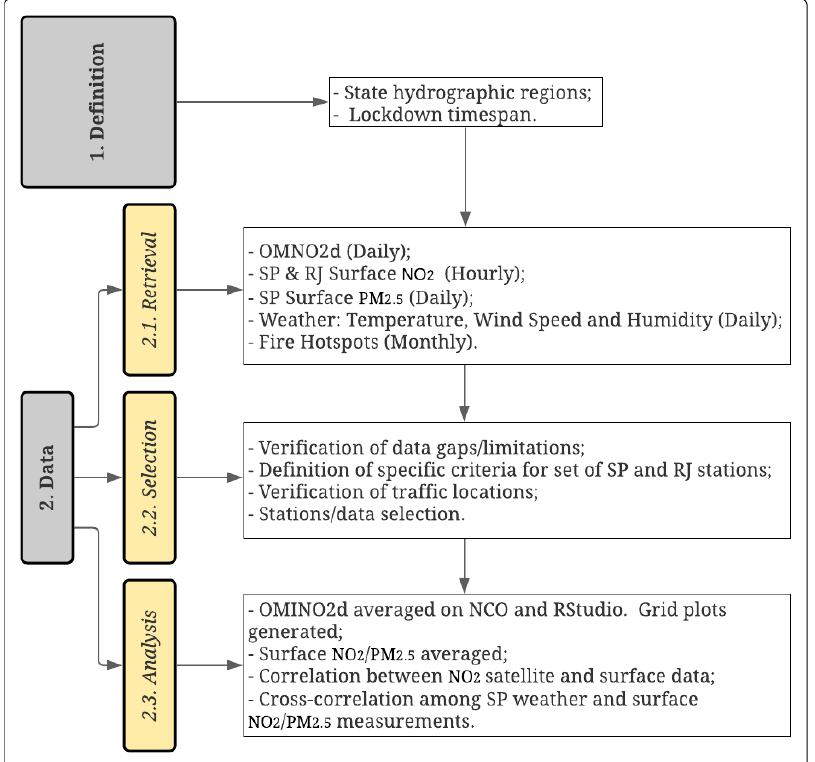
Figure 2. The workflow diagram for data analysis in this